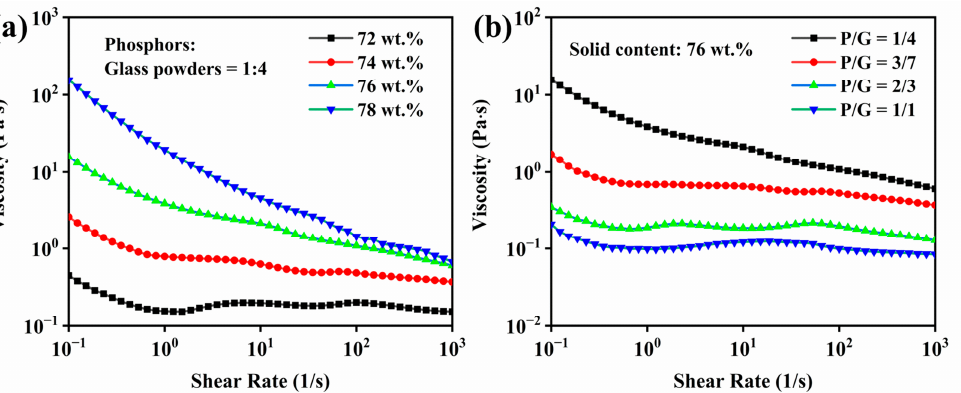
Figure 3. ( a ) Rheology properties of different solid contents in the same ratio and ( b ) different ratios in the same solid content.